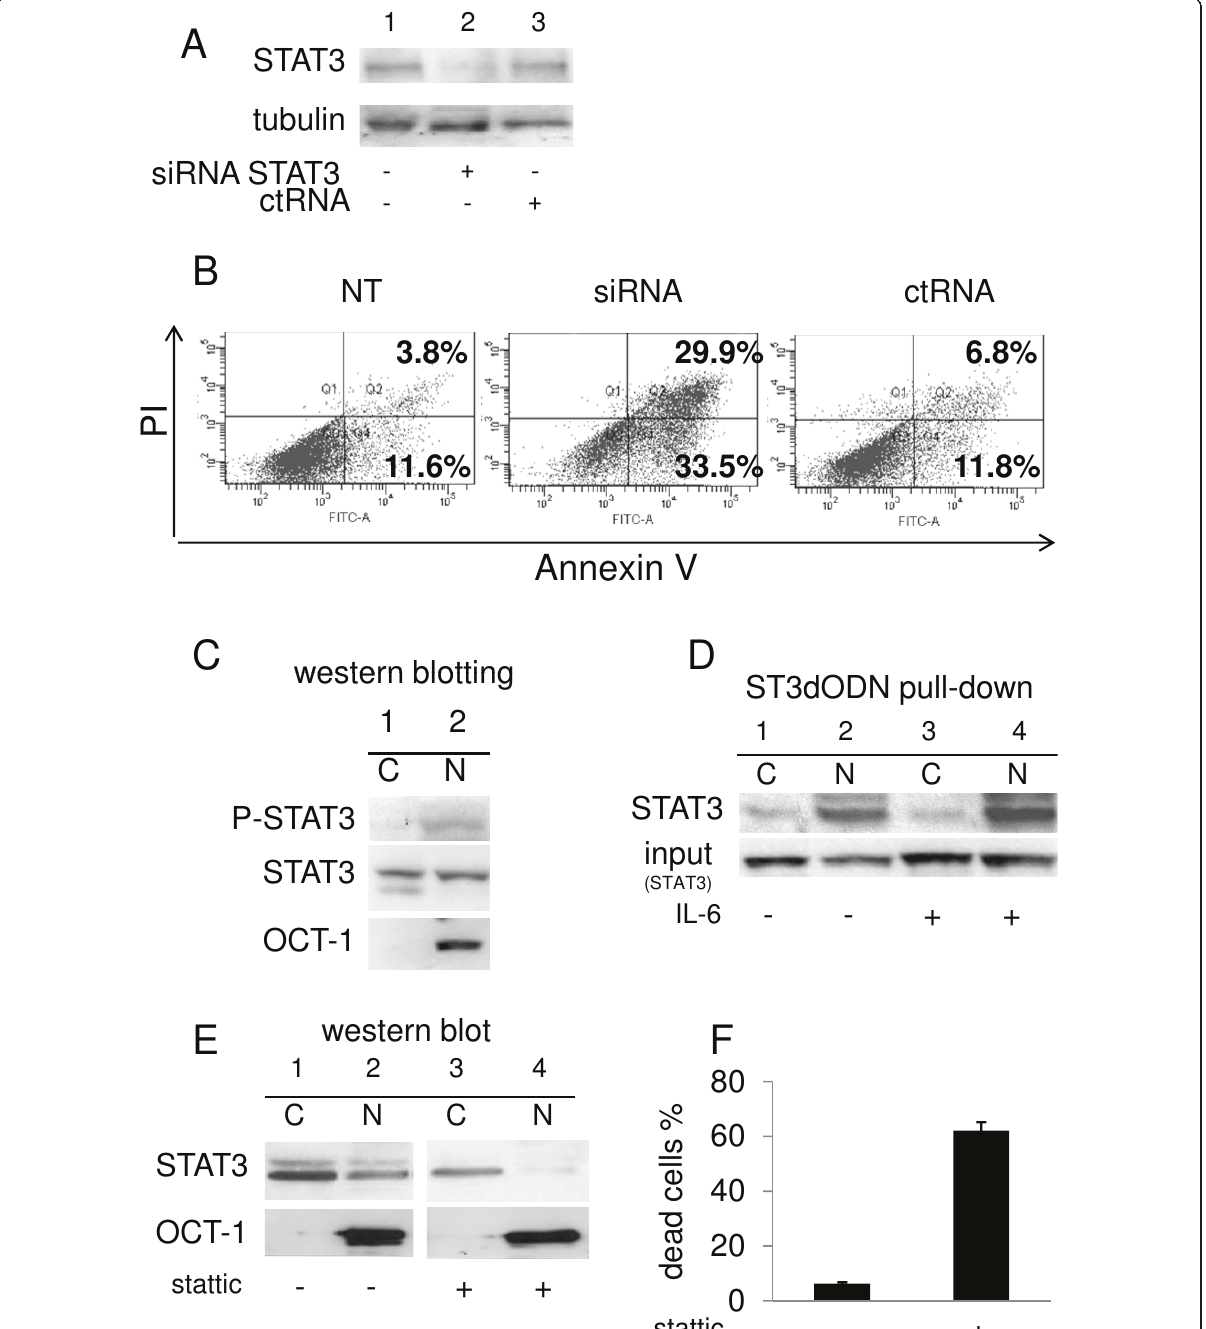
Figure 1 STAT3 activation is required for SW 480 colon carcinoma cell survival . A : Western blotting of STAT3 in cells not transfected with siRNA (lane 1) or transfected with either STAT3 siRNA (lane 2) or control siRNA (lane 3). B : Detection by cytometry of annexin V and propidium iodide (PI)-positive cells in the absence of transfection (NT), or after transfection with STAT3 siRNA (siRNA) or control siRNA (ctRNA). A typical experiment is shown. C : Western blotting of phospho-STAT3 and STAT3 in cytoplasmic (C) and nuclear (N) fractions of non-treated SW 480 cells. OCT-1 was used as nuclear marker control. D : Pull-down with biotinylated STAT3-decoy ODN using cytoplasmic (lanes 1 and 3) and nuclear (lanes 2 and 4) extracts from untreated (lanes 1 and 2) or IL-6-treated (50 ng/ml, 1 h) cells (lanes 3 and 4). E : Western blotting of phospho-STAT3 and STAT3 in cytoplasmic (C) and nuclear (N) fractions of non-treated SW 480 cells (1, 2) or Stattic-treated cells (20 μ M). OCT-1 was used as nuclear marker control. F : Measurement of cell death using trypan blue-staining and counting with a V-cell automatic apparatus. Cells were either not treated or treated with Stattic (20 μ M, 48